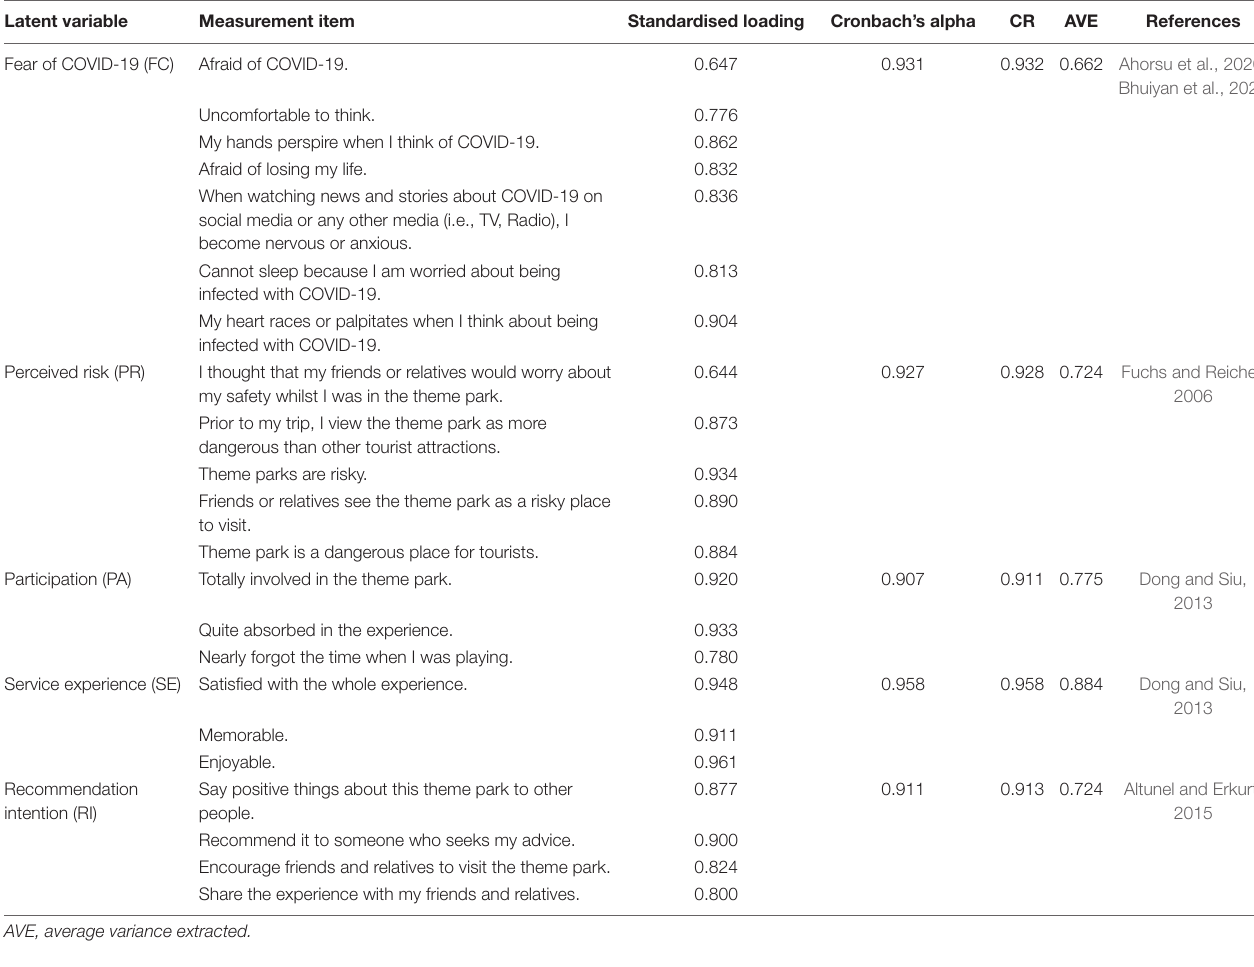
TABLE 2 | Confirmatory factor analysis results.